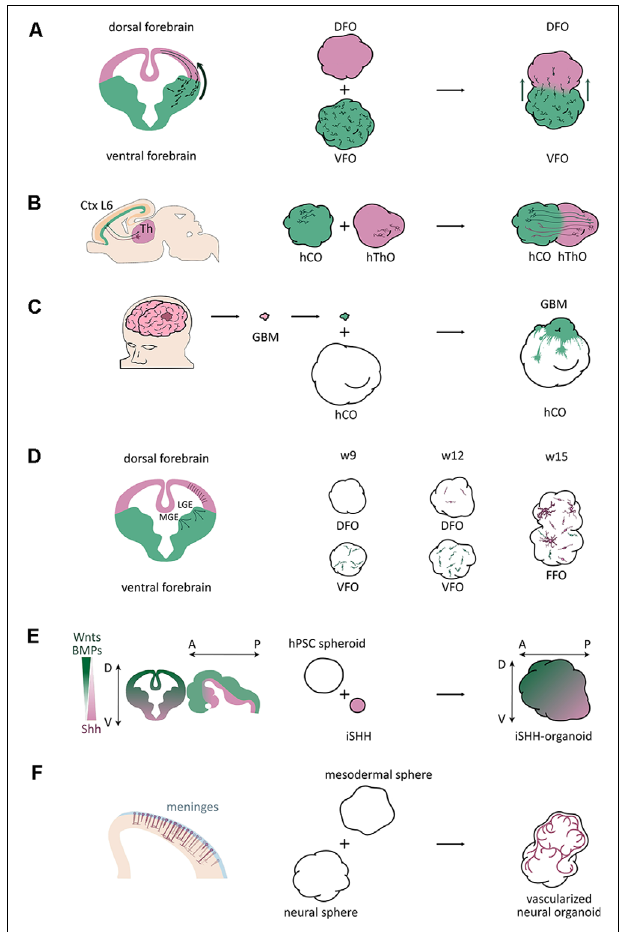
FIGURE 1 | Schematic of application of fused organoid models studying human brain development and disorders. (A) A scheme of interneuron migration from ventral to dorsal areas in the mouse brain and fused organoid models (Bagley et al., 2017). DFO, dorsal forebrain organoid; VFO, ventral forebrain organoid. (B) A scheme of neuronal projections between the neuronal layer 6 of the cortical plate and the thalamus in the mouse brain and fused organoid models (Xiang et al., 2019). Ctx, cortex; L6, layer 6; Th, thalamus; hThO, human thalamic organoid; hCO, human cortical organoid. (C) A scheme of a brain tumor invasion model by fusing patient-derived tumorspheres with brain organoids (Linkous et al., 2019). GBM, glioblastoma multiforme; hCO, human cortical organoid. (D) A scheme of the three oligodendrogenic waves in the mouse brain and a scheme of oligodendrogenesis in brain organoids (Kim et al., 2019). MGE, medial ganglionic eminence; LGE, lateral ganglionic eminence; DFO, dorsal forebrain organoid; VFO, ventral forebrain organoid; FFO, fused forebrain organoids; w9, w12, w15, week 9, 12, 15. (E) A scheme of axis establishment in the mouse central nervous system (CNS) and a scheme of a SHH gradient-induced forebrain axis establishment of brain organoids (Cederquist et al., 2019). iSHH, induced Sonic hedgehog sphere; D, dorsal; V, ventral; A, anterior; P, posterior. (F) A scheme of vascularization in the developing mouse cortex and a scheme of brain organoid vascularization (Wörsdörfer et al.,